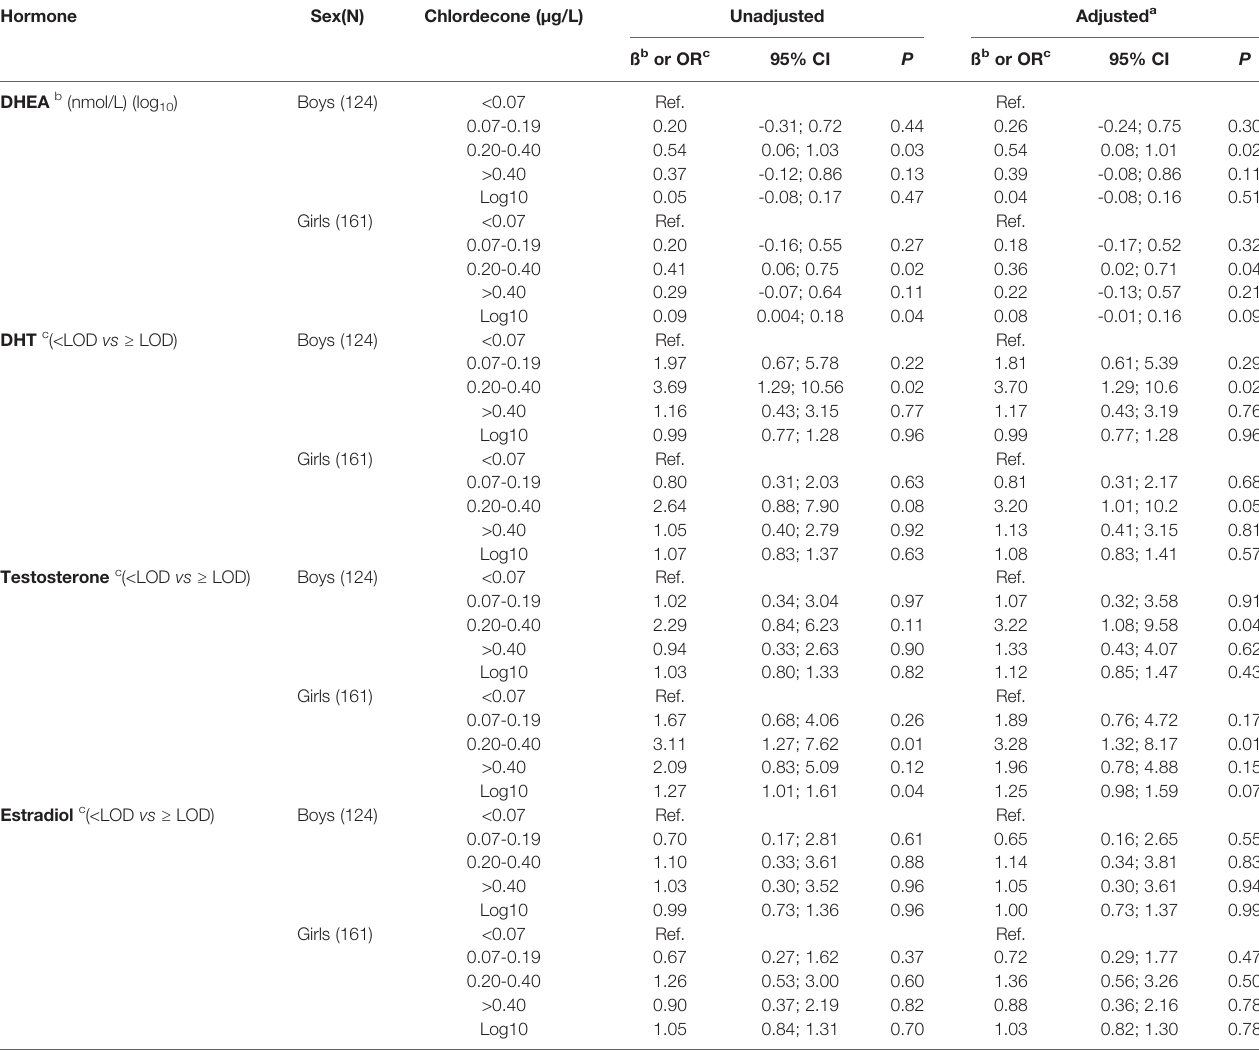
TABLE 6 | Associations between in utero (cord blood) chlordecone exposure and steroid hormone concentrations at seven years of age in children of the TIMOUN cohort. Hormone Sex(N) Chlordecone (µg/L) Unadjusted Adjusted a ß b or OR c 95% CI P ß b or OR c DHEA b (nmol/L) (log 10